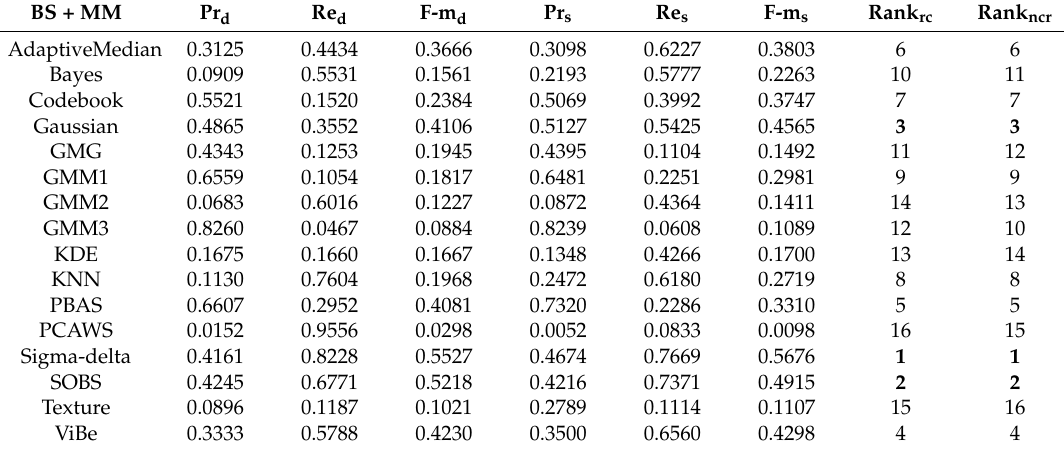
Table 13. Evaluation metrics and ranks of the evaluated BS with median filter and morphological operation.